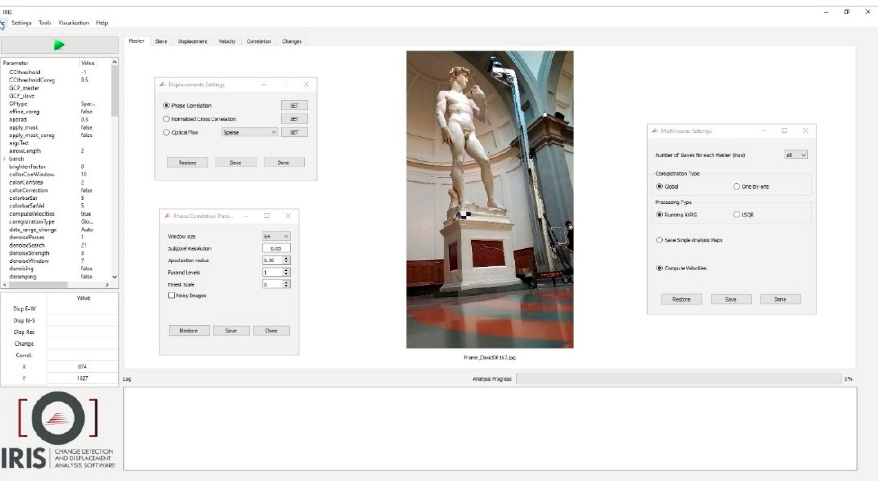
Figure 8. Preview of the IRIS Software by NHAZCA S.r.l.